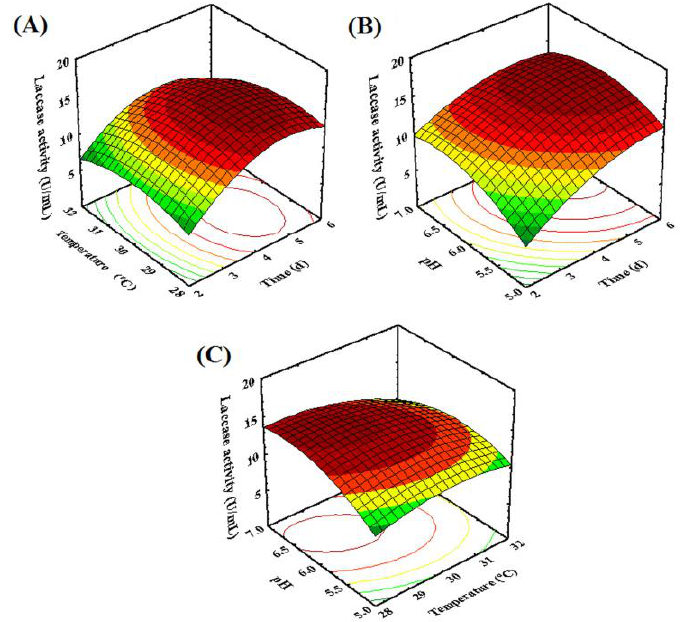
Figure 3. Response surfaces plots for the laccase production by M. verrucaria MD-R-16: ( A ) varying the fermentation temperature and time; ( B ) varying the fermentation time and pH of the initial fermentation medium; ( C ) varying the fermentation temperature and pH of the initial fermentation medium.